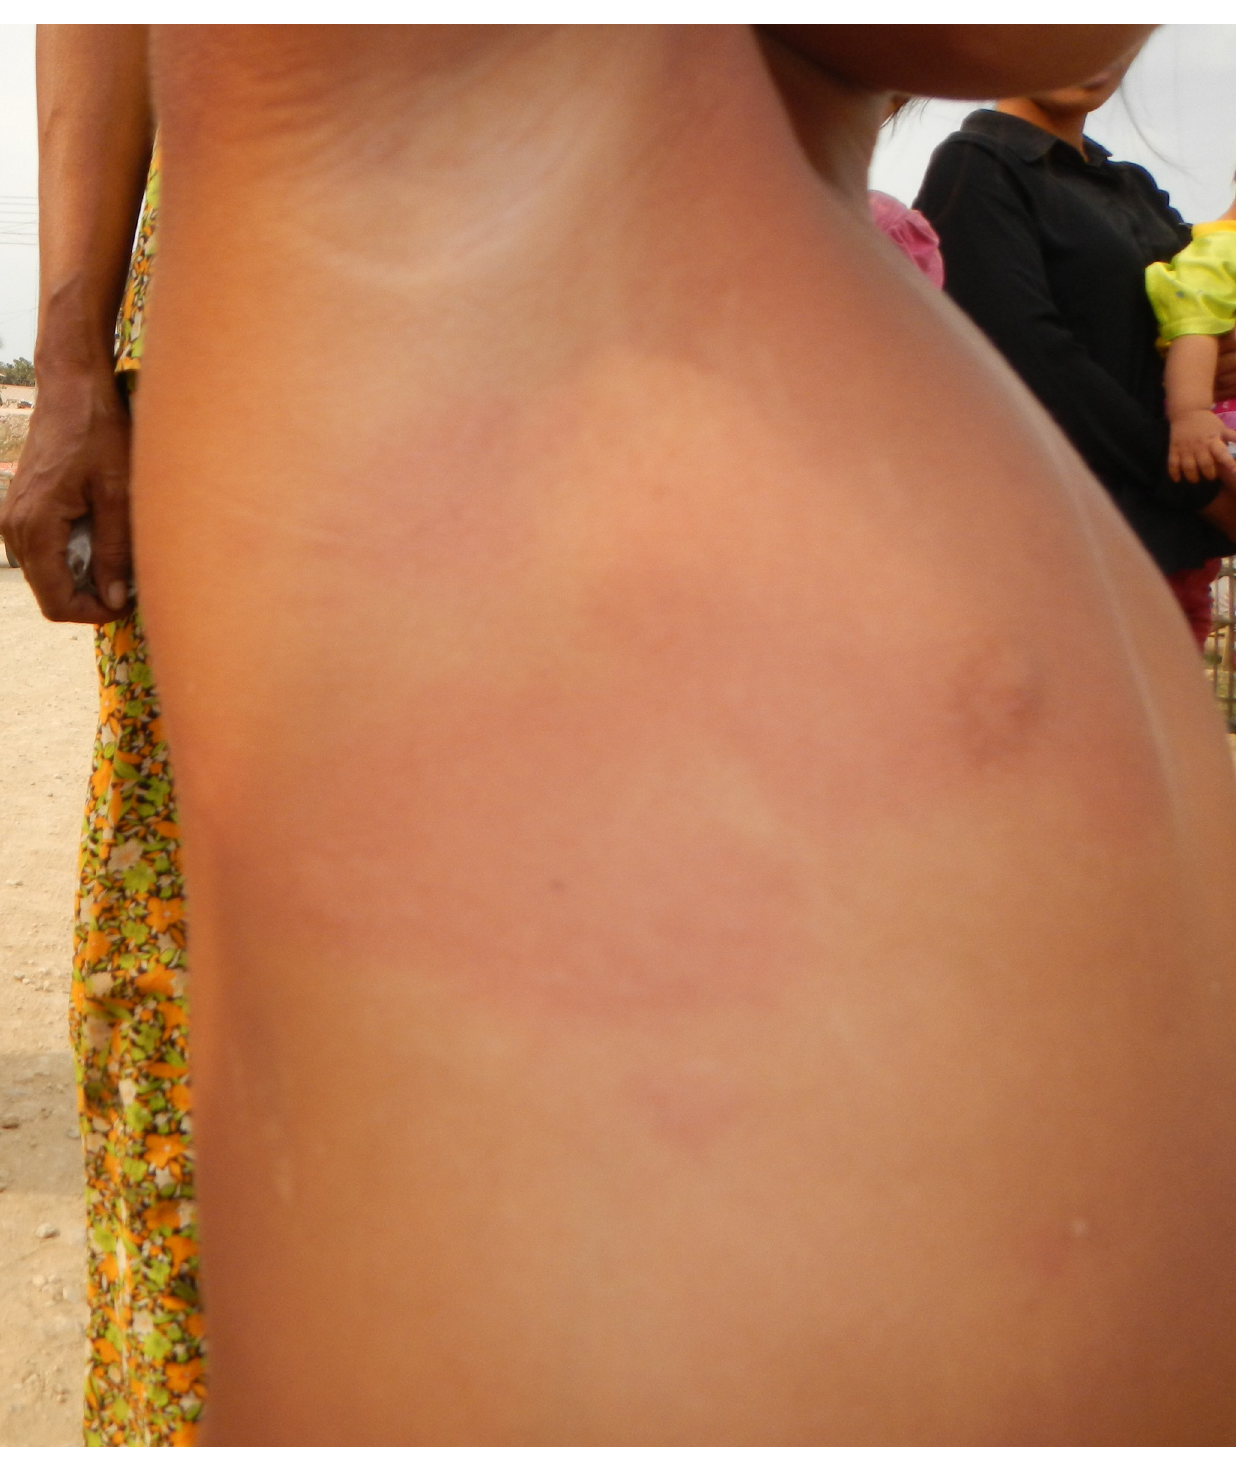
PLOS ONE | https://doi.org/10.1371/journal.pone.0269480 June 9,